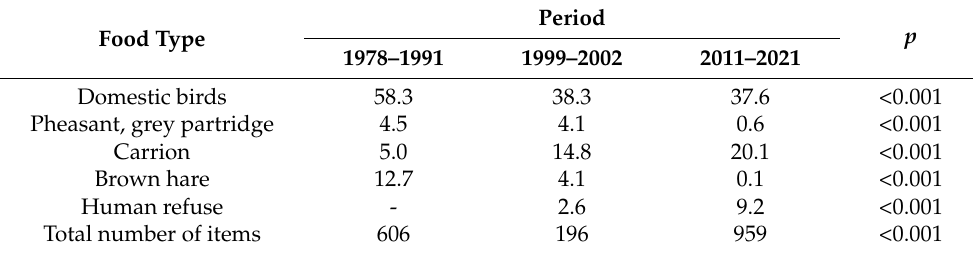
Table 3. Changes in the share of selected food categories (% of all food items recorded) in the red fox diet in Rog ó w (central Poland), in the three periods, as based on the food remains collected at natal dens. Results of the Fisher (two-tailed) exact test are given. Bonferroni corrected p -value of 0.01. In the case of human refuse, only the second and third periods were compared. Source of data: Table